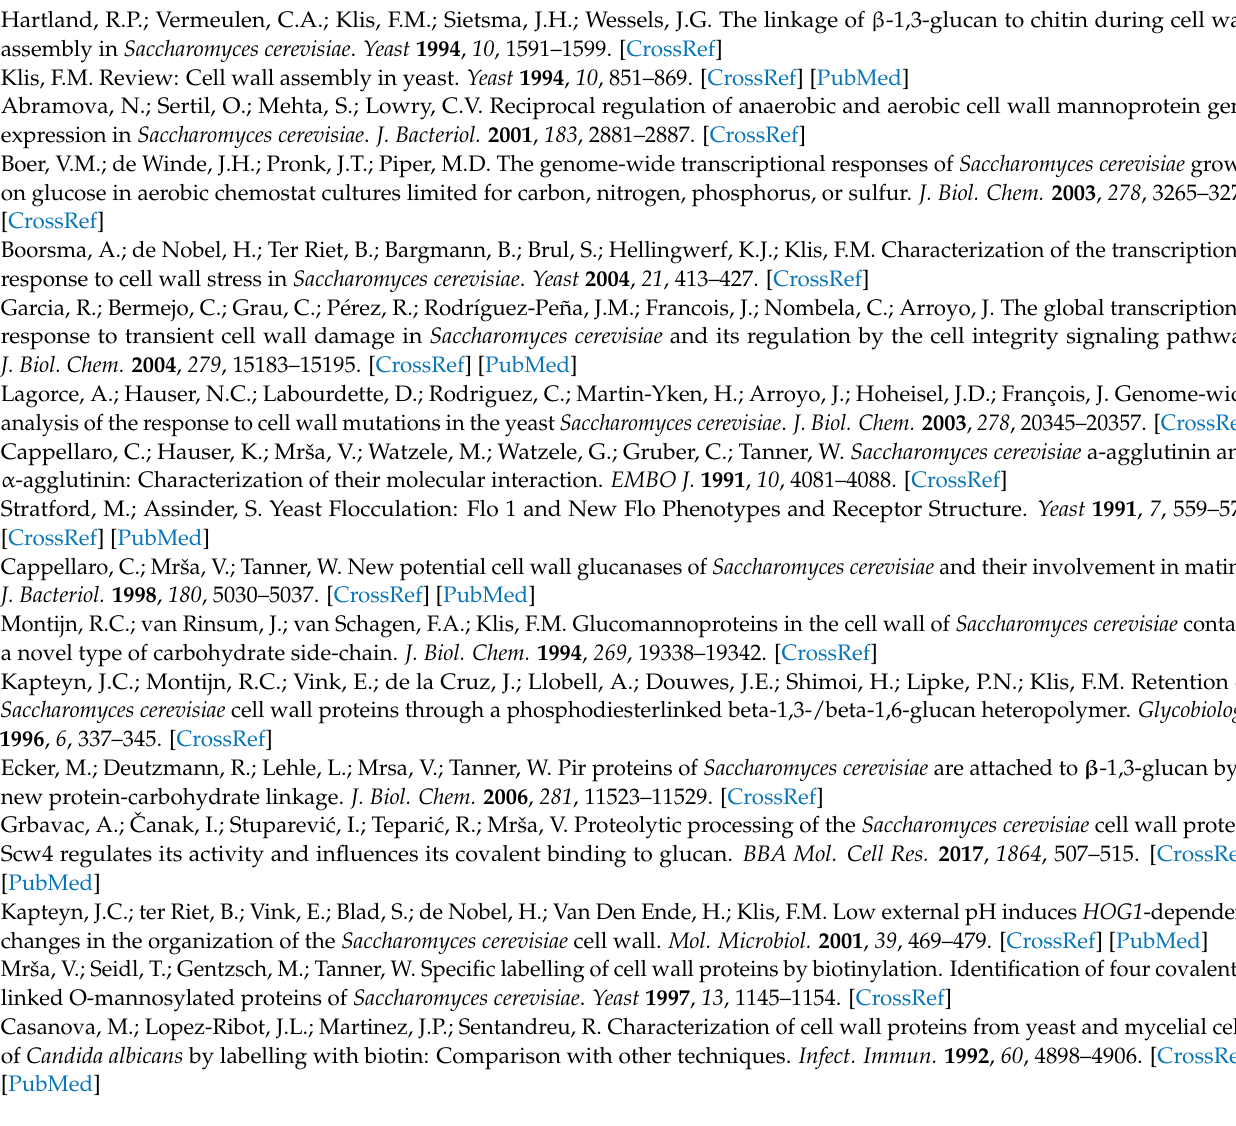
Table S2 Yeast strains used in the electrophoretic analysis of the cell wall